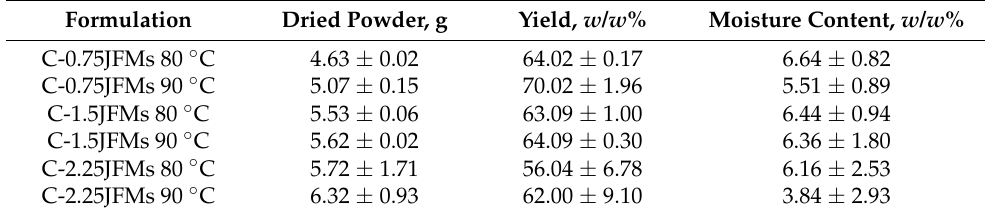
Table 1. Properties and data analysis of microcapsules. Formulation